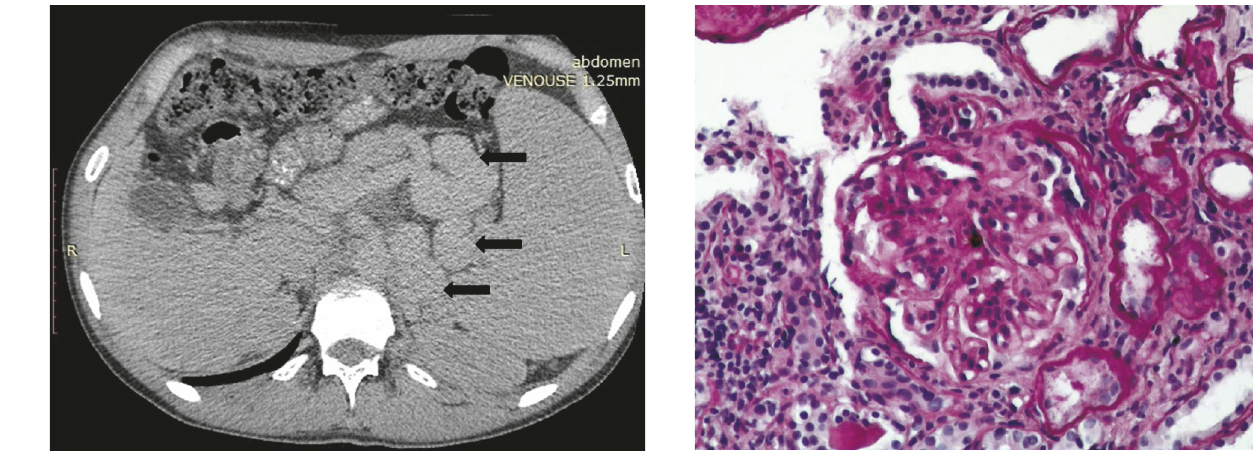
Figure 1: Axial postcontrast CT shows voluminous splenorenal collaterals (arrows).